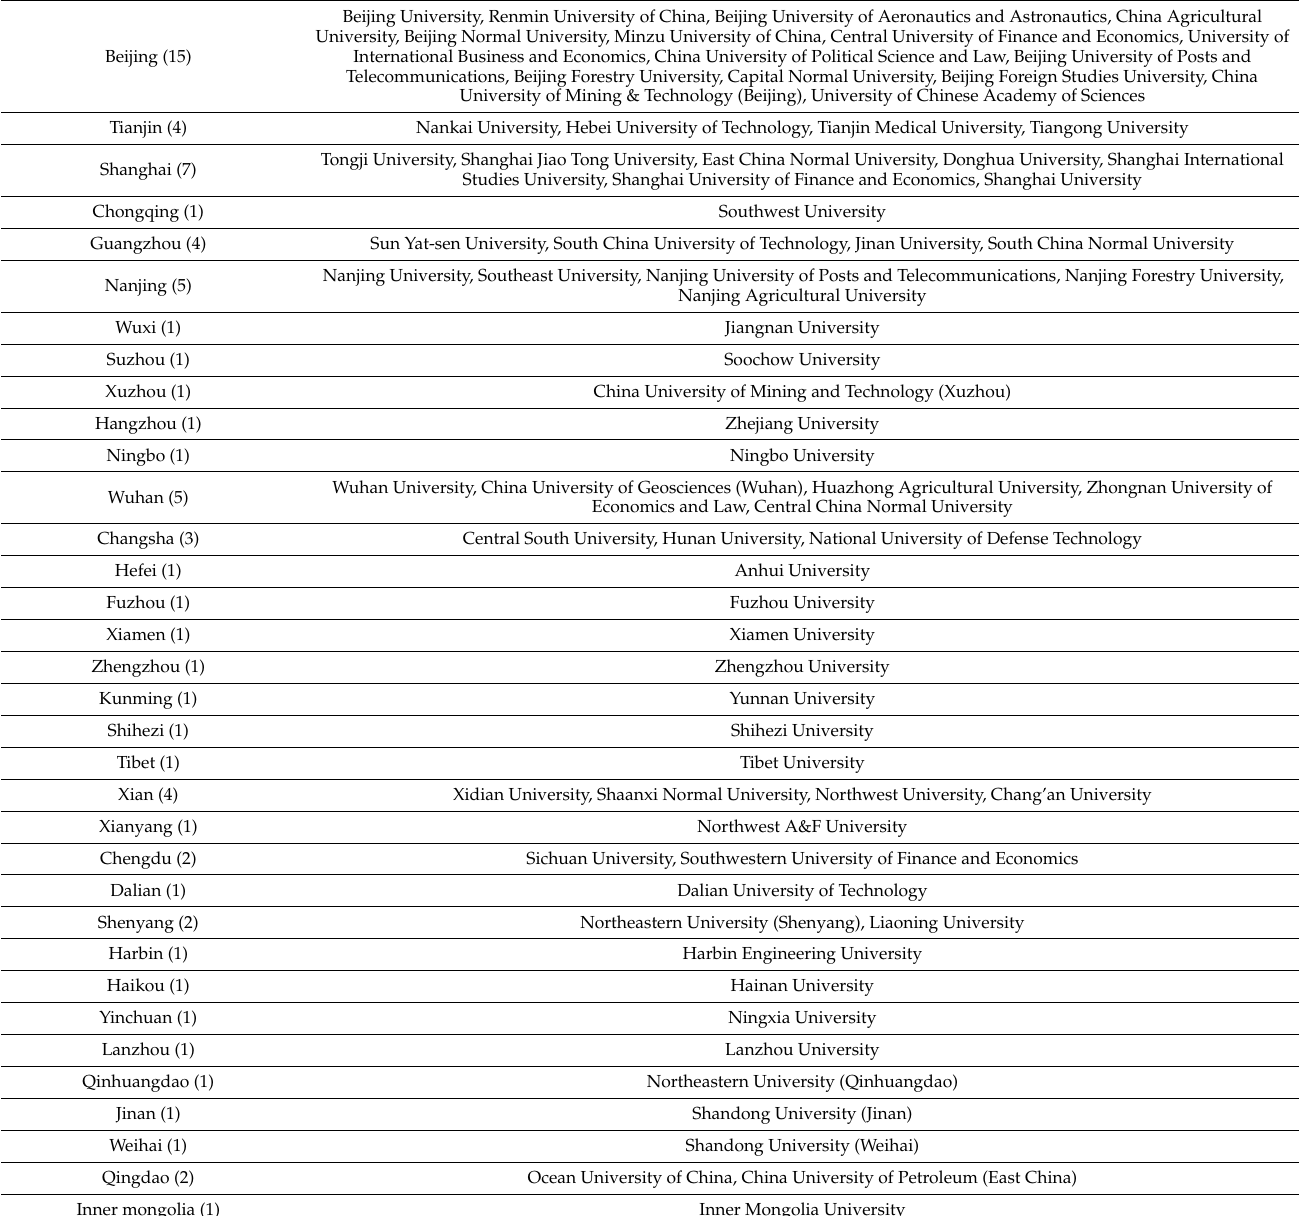
Table A1. List of 76 double first-class